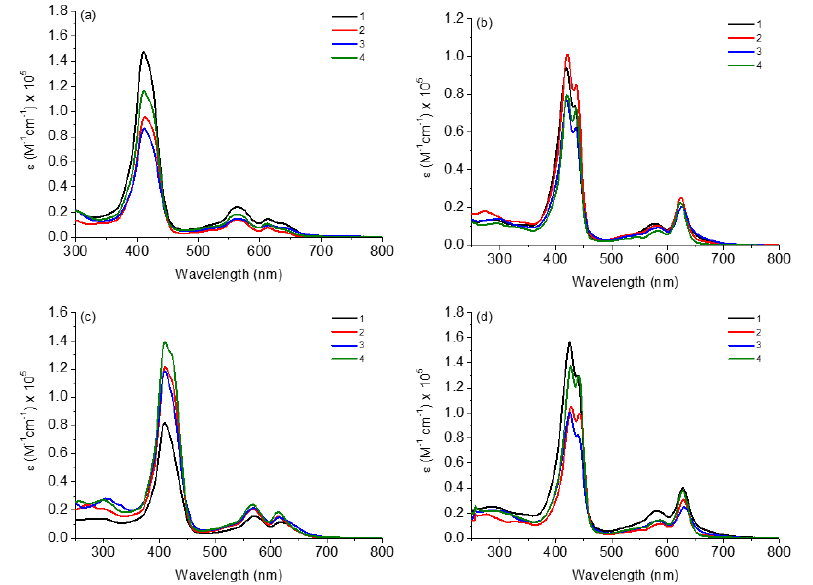
Figure 2. Absorption UV-Vis spectra of corroles 1 – 4 in ( a ) DCM, ( b ) ACN, ( c ) MeOH and ( d ) DMSO, at concentration of 10 µ M.